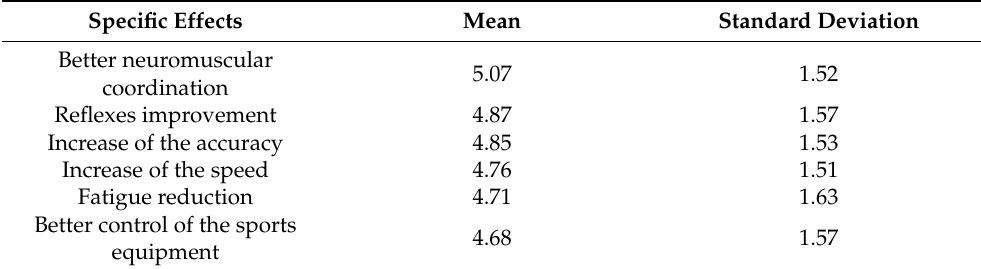
Table 9. Level of interest in the specific effects of caffeine on sports performance.